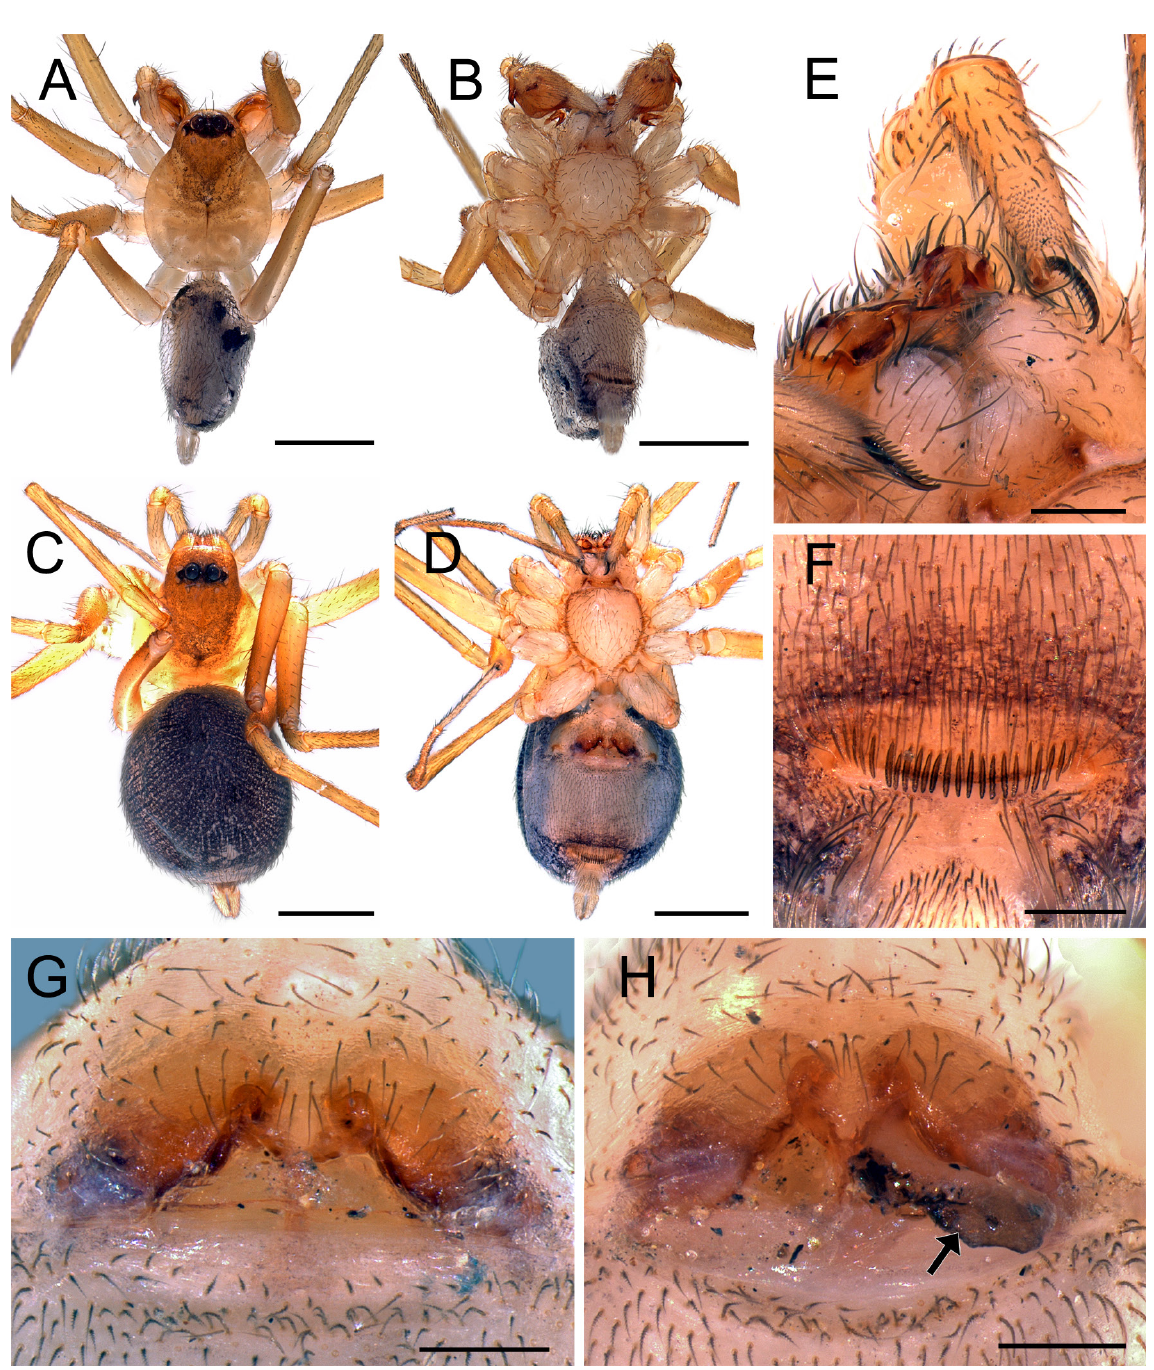
Fig. 5. Acanthinozodium sahelense sp. nov. A–B . ♂ from Faro Game Reserve (MRAC 221205). C–H . ♀♀ from same sample. A . Male habitus, dorsal view. B . Idem, ventral view. C . Female habitus, dorsal view. D . Idem, ventral view. E . Female, mouthparts and palps, ventral view. F . Female, abdomen, modified setae in front of tracheal spiracle, ventral view. G . Epigyne, ventral view. H . Epigyne, other specimen; arrow indicates plug. Scale bars: A–D = 1 mm; E–F = 0.2